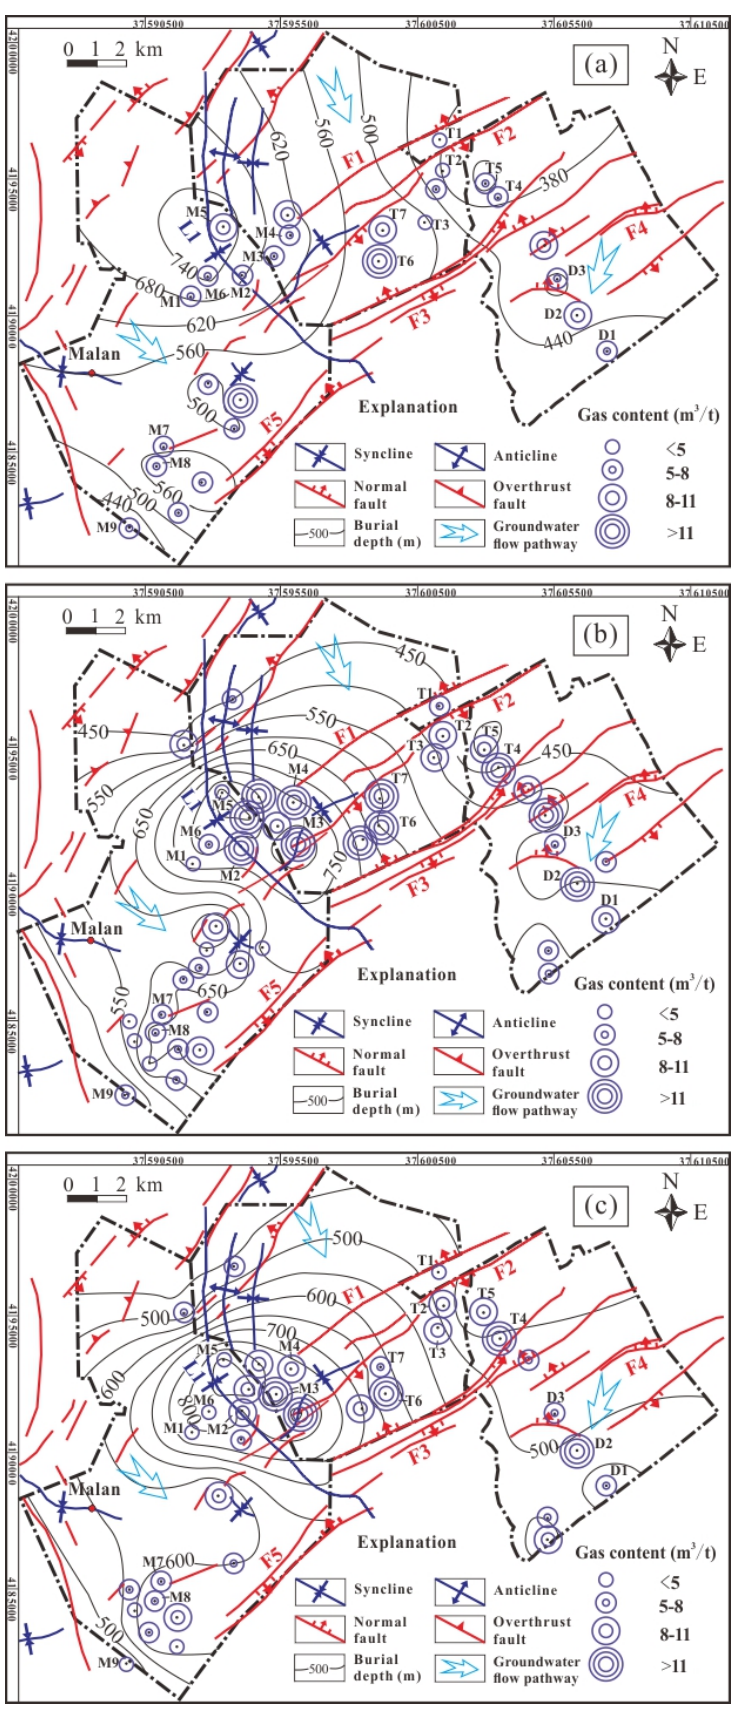
Figure 4. Gas content associated with burial depth for coal seams in the Gujiao area. ( a ) No. 2 coal; ( b ) No. 8 coal; ( c ) No. 9 coal.